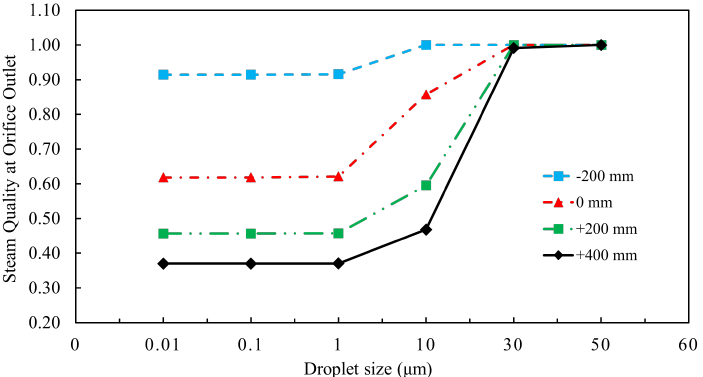
Figure 19. Steam quality at the orifice outlet for various droplet sizes and vane